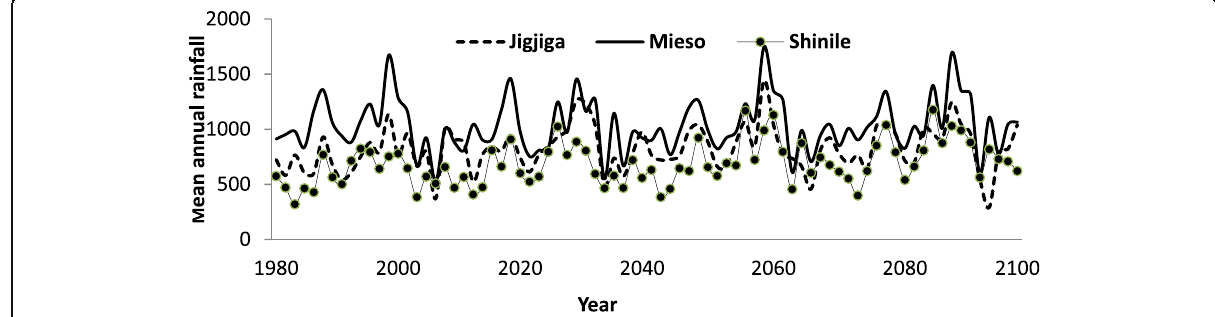
Fig. 4 Trends of current and future mean annual rainfall for Mieso, Jigjiga, and Shinile districts for the period 1984 –